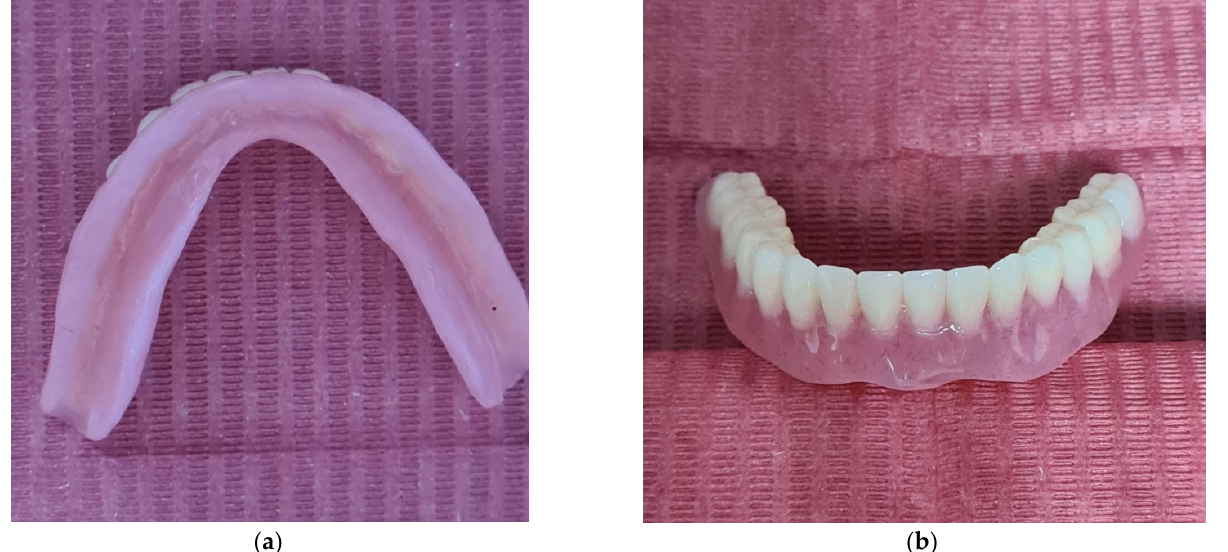
Figure 15. Final lower denture ( a ) mucosal view; ( b ) external view.